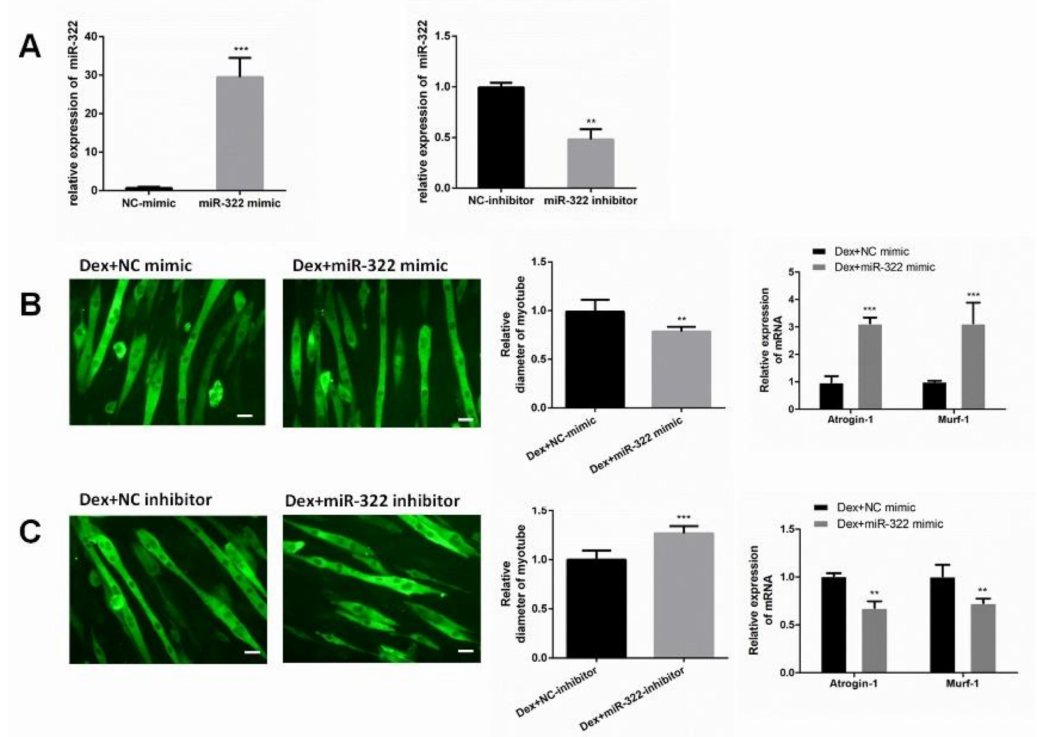
Figure 3. miR-322 aggravated Dex-induced atrophy in C2C12 myotubes. ( A ) miR-322 mimic increased the miR-322 expression, and miR-322 inhibitor decreased the miR-322 expression in C2C12 myotubes. ( B ) Immunofluorescent staining for MyHC in C2C12 myotubes showed the reduced myotube diameter and increased Atrogin-1 and MuRF-1 expression levels after transfection with miR-322 mimic in C2C12 myotubes. ( C ) Immunofluorescent staining for MyHC in C2C12 myotubes showed the increased myotube diameter and inhibited Atrogin-1 and MuRF-1 expressions after transfection with miR-322 inhibitor in C2C12 myotubes. Scale bar, 10 µ m. Con, control. Dex, dexamethasone. ** p < 0.01 and *** p <